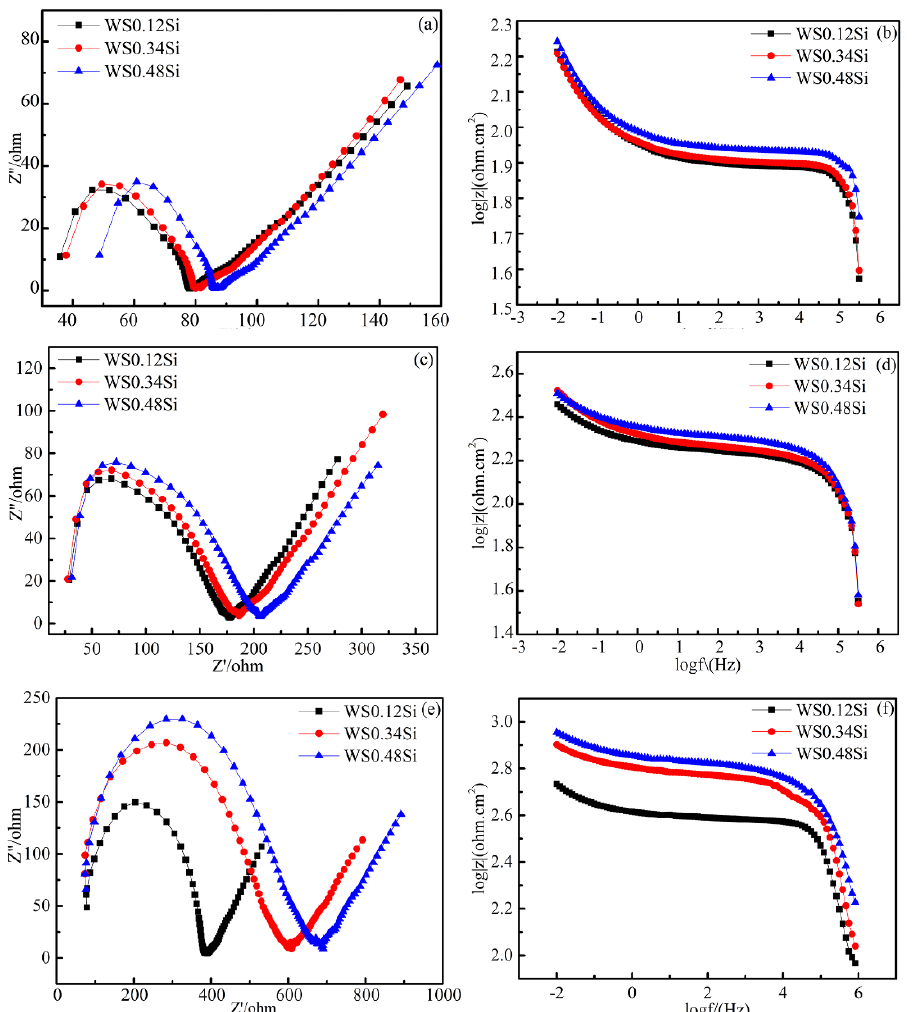
Figure 8. Nyquist plots and Bode diagrams of three experimental steel groups at ( a , b ) 6th cycle, ( c , d ) 30th cycle, and ( e , f ) 120th cycle.